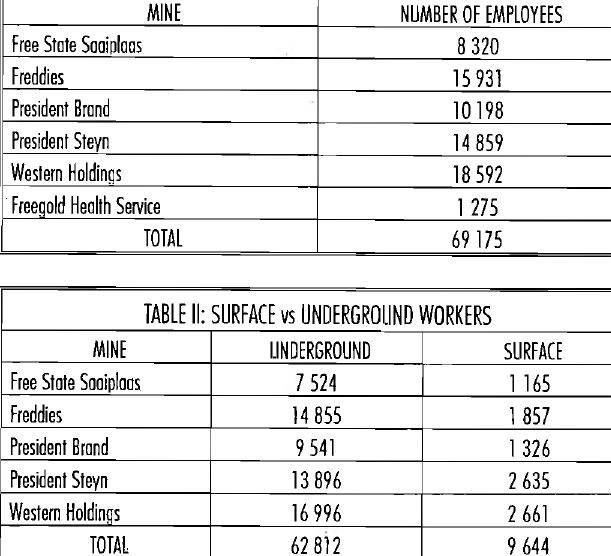
TABLE 1: BREAKDOWN OF EMPLOYEES